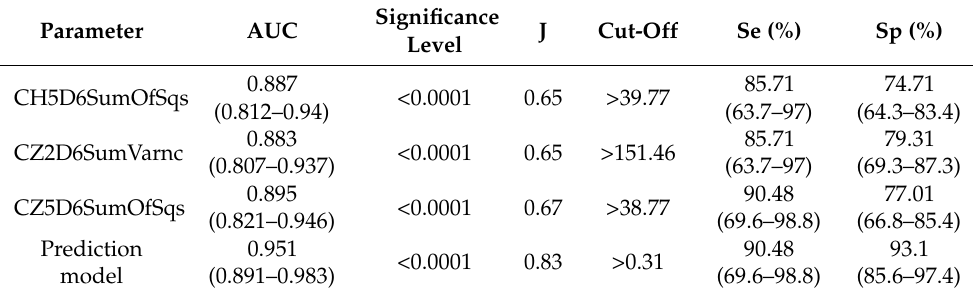
Table 3. The receiver operating characteristic analysis results of the parameters that are independently associated with the presence of ovarian malignancy and the prediction model consisting of these parameters. Between the brackets are the values corresponding to the 95% confidence interval.